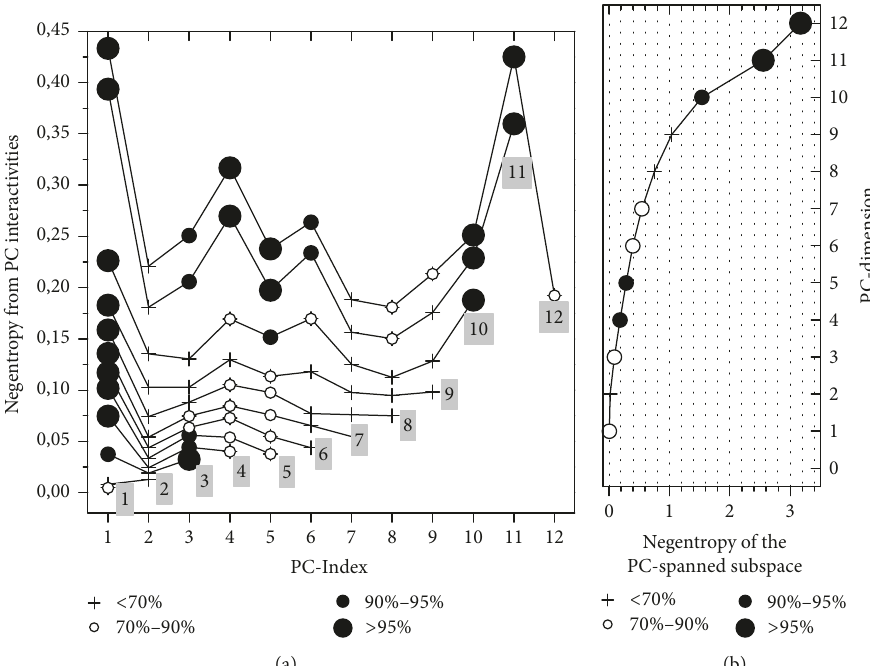
̃ M [ y ] ( 𝑘 in abscissas) for each 𝑁 = 1,...,12 (marked in grey shaded). (b) Total NE ̃𝐽 𝑘𝑘 (𝑁)